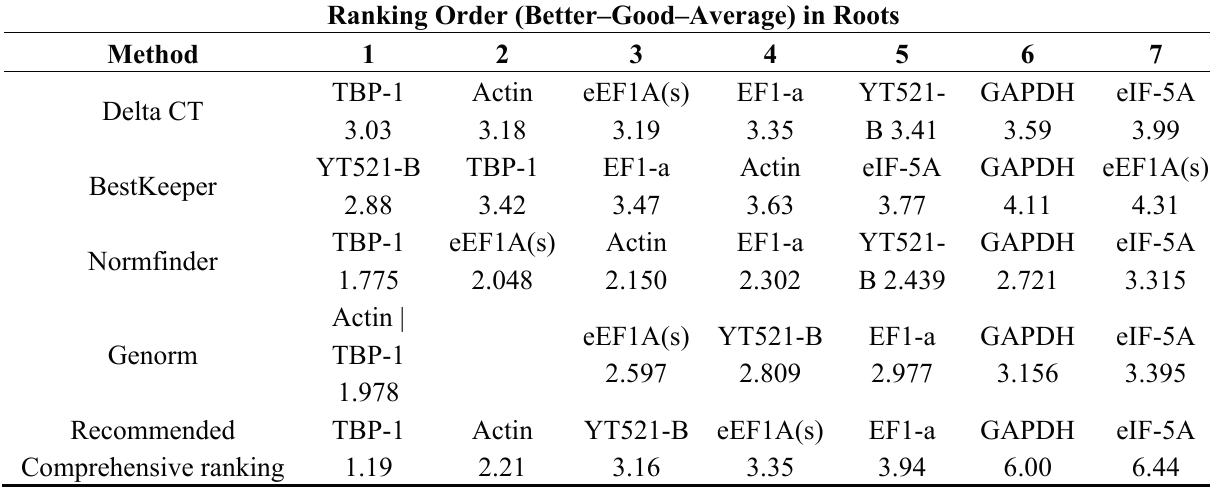
Table 3. Evaluation of the expression stabilities of candidate internal reference genes in roots of annual